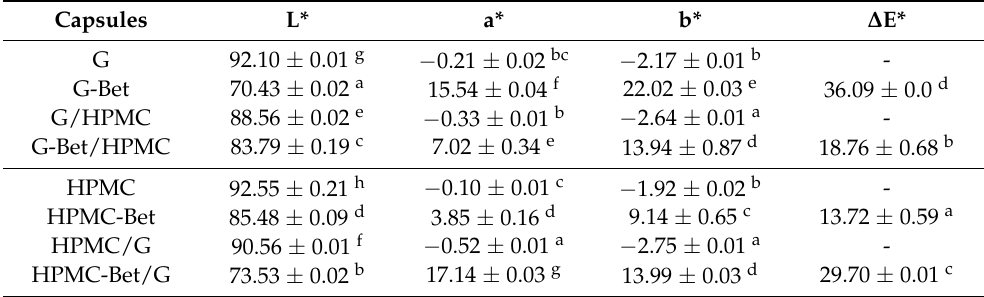
Table 2. Color parameters of uniaxial and coaxial